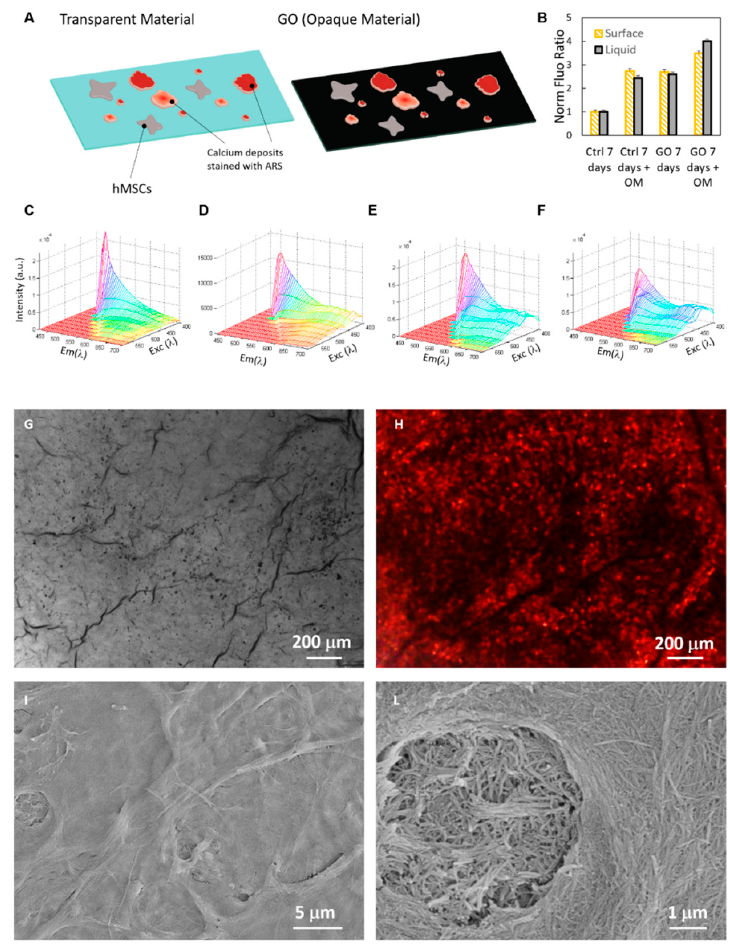
Figure 4. ARS quantification on graphene oxide (GO) substrates. As is visible from the schematic illustrations, we compared the quantification of calcium deposits on transparent substrates, i.e., glass, and on opaque materials i.e., GO ( A ). Results of fluorescence analysis of different samples are reported in histogram ( B ). 2D spectra of samples on glass after seven days ( C ), on glass seven days after OM induction ( D ), on GO after seven days ( E ) and on GO seven days after OM induction ( F ). Representative bone matrix on the GO surface imaged with optical microscopy ( G ), fluorescence ( H ) and scanning electron microscopy ( I , L ),